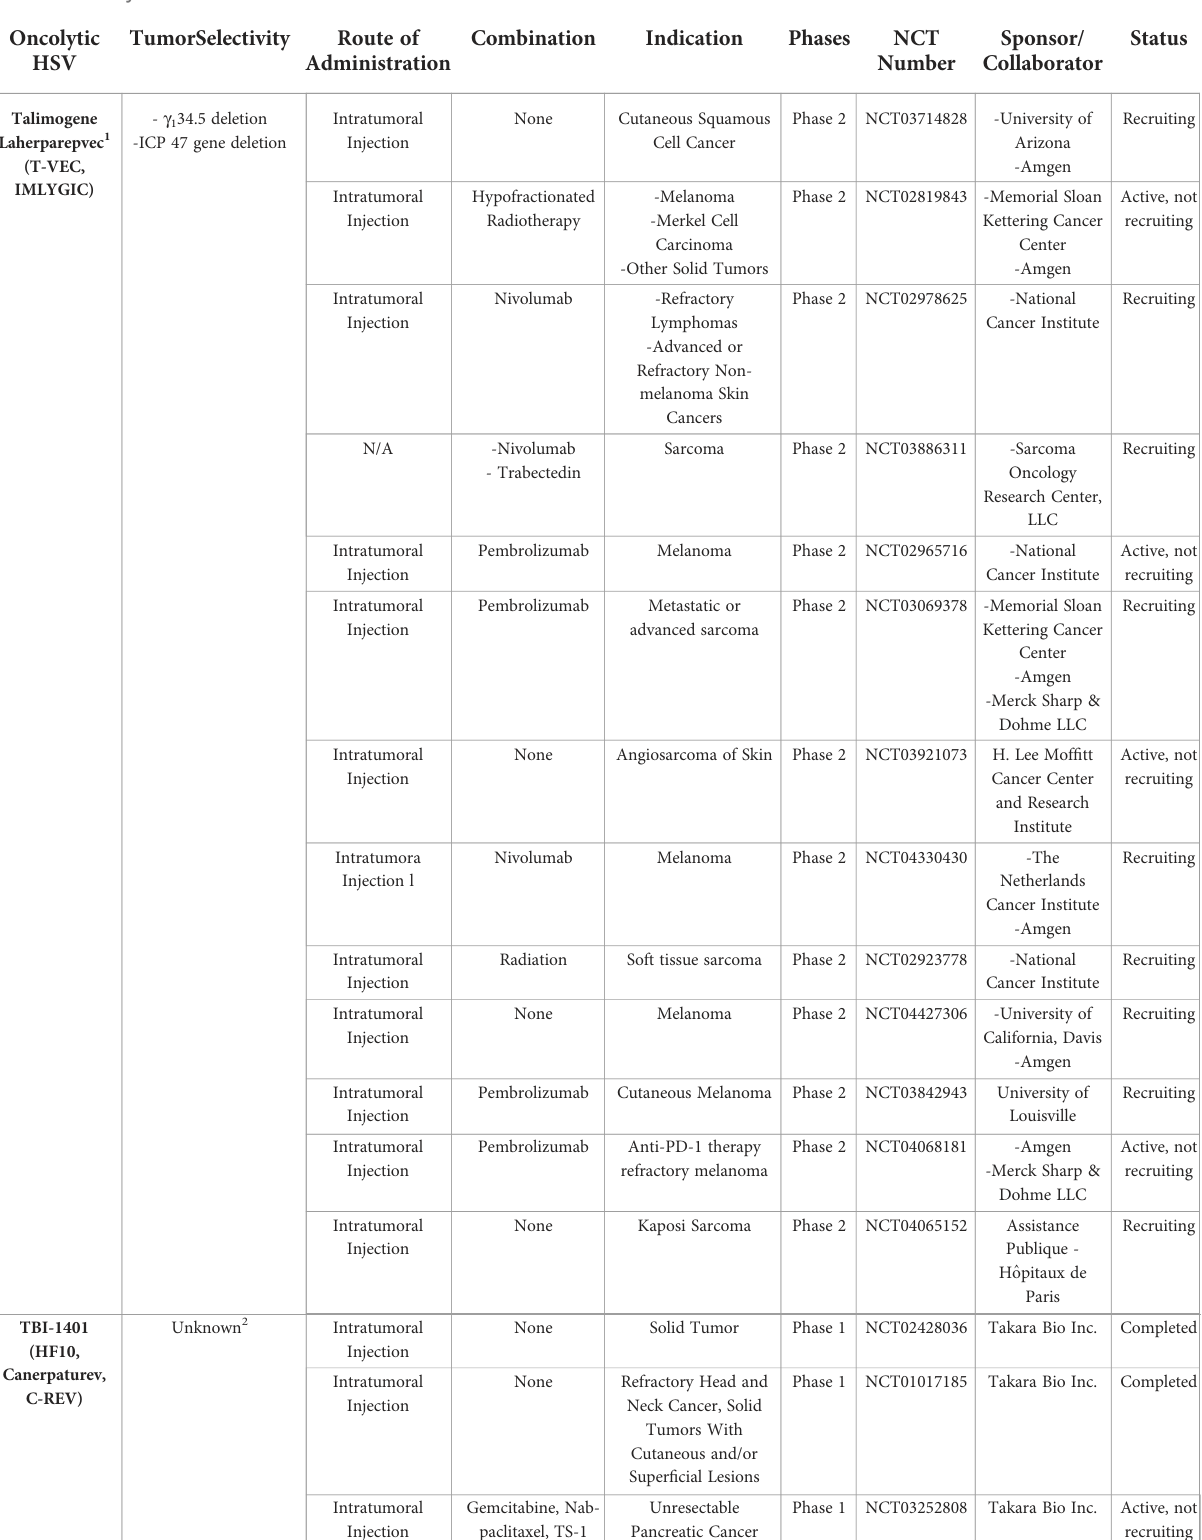
TABLE 2 Oncolytic HSVs tested in current clinical